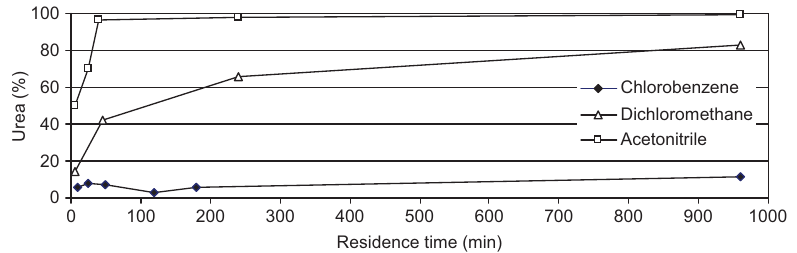
Figure 5 Effect of residence time in fed-batch mode on conversion of 1 into 3 . (20 ° C; R